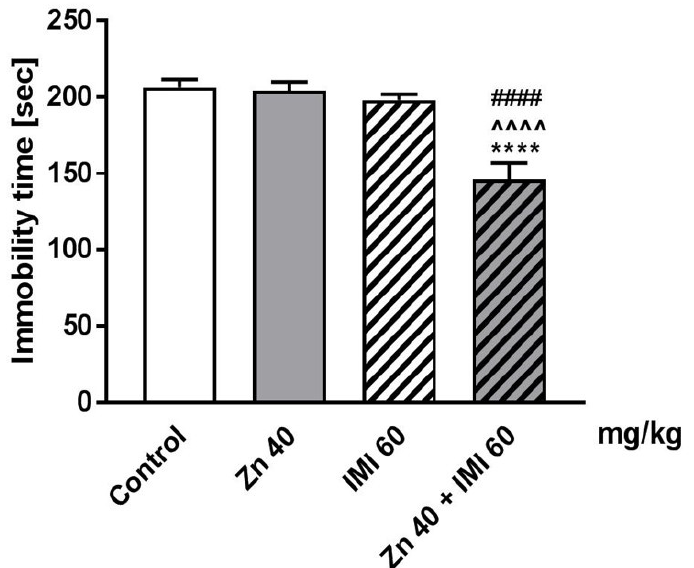
Figure 1. E ff ect of combined treatment of Zn and IMI in the FST in mice. Zn (40 mg Zn / kg), IMI (60 mg / kg), and NaCl (control) were administered p.o. 60 min before the test. Results are expressed as mean ± S.E.M (n = 9–10 per group). **** p < 0.0001 vs. control group, ˆˆˆˆ p < 0.0001 vs. IMI